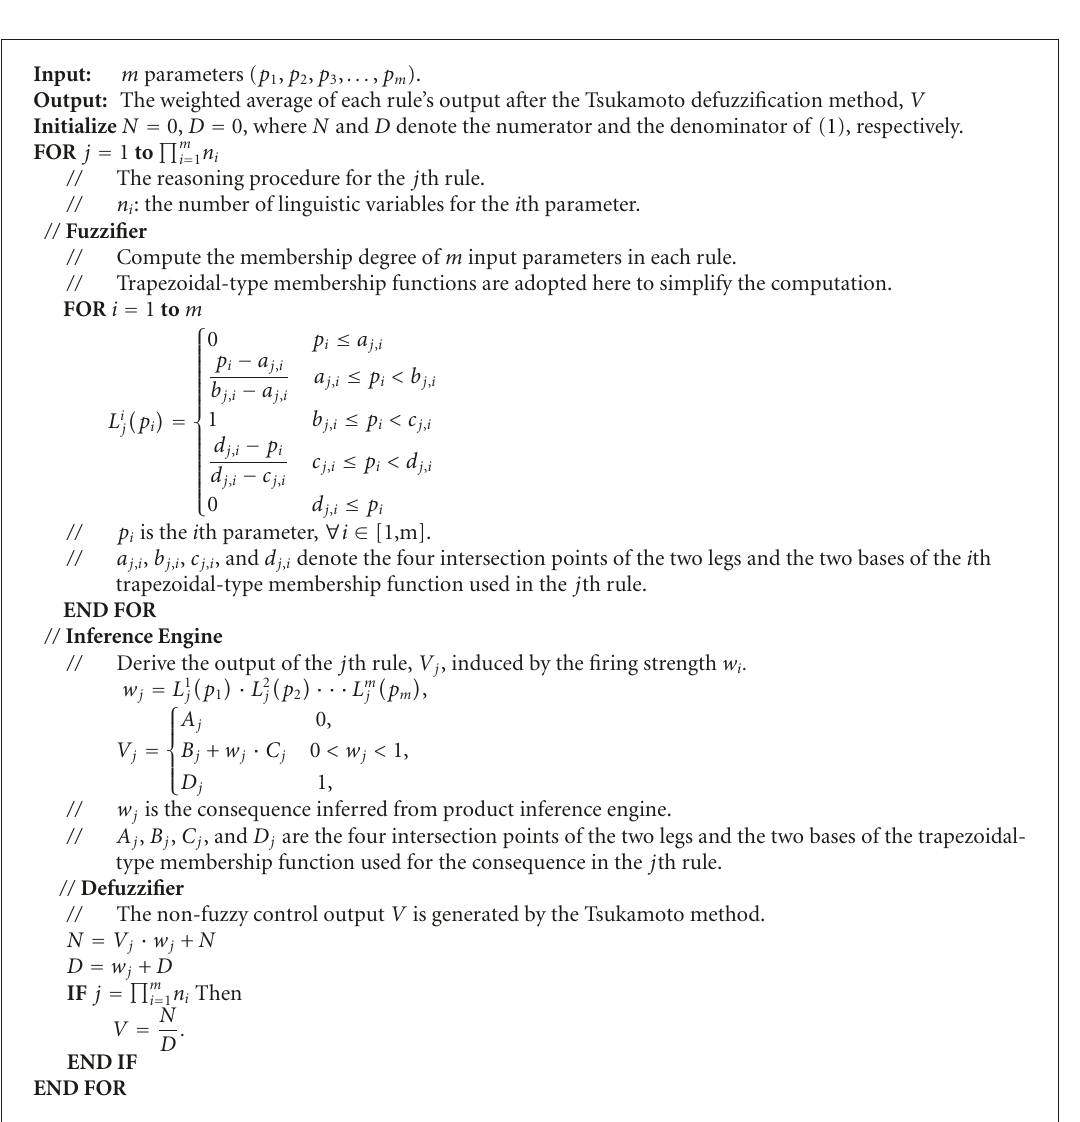
Algorithm 1: Fuzzy logic